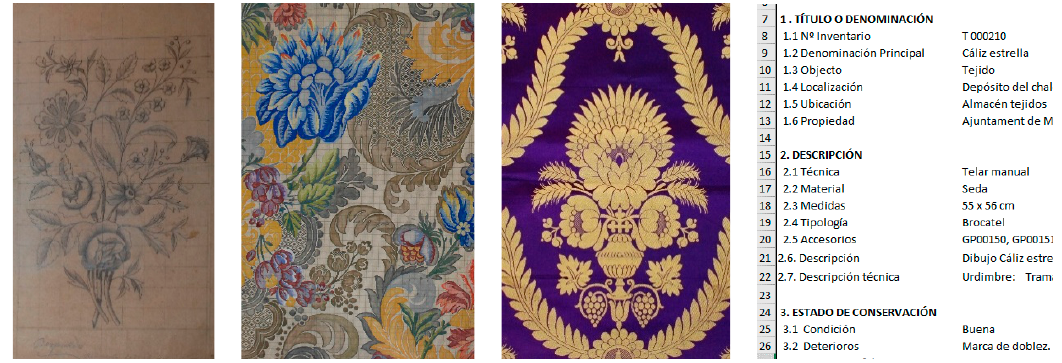
Figure 3. Examples of types of input data considered for the project. Images from left to right: a sketch; a technical drawing; a silk textile; and text associated with an image. Images belong to Garín 1820 S.A. [21].